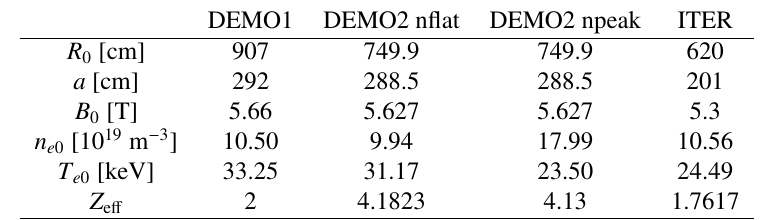
Table 1. Global tokamak parameters employed in the analysis of the ECCD e ffi ciency. Additionally, a half-temperature DEMO1 case has been considered.